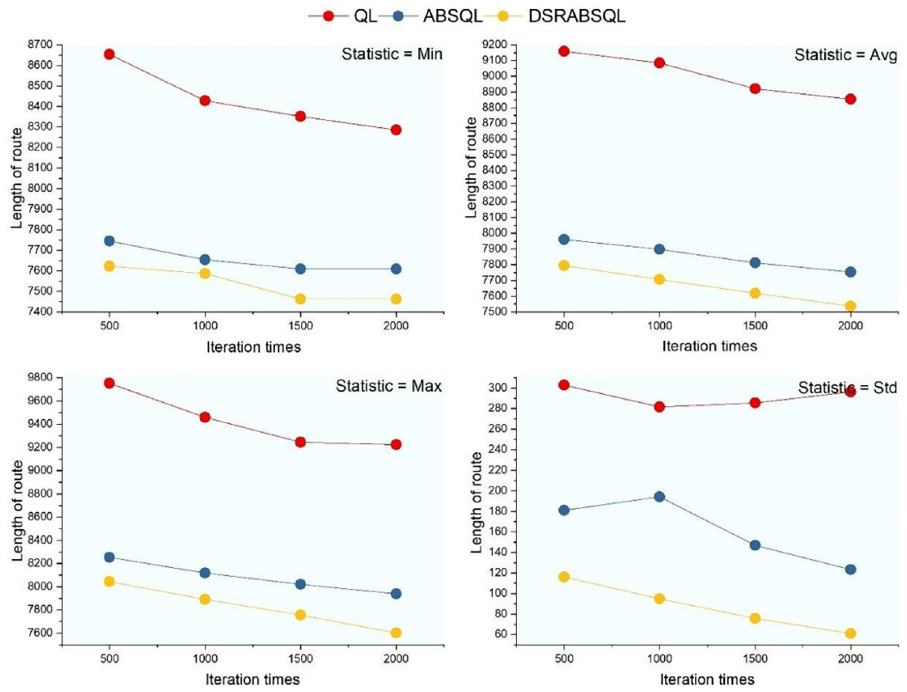
Fig 8. min , avg , max and S td for rat575 obtained by three algorithms.